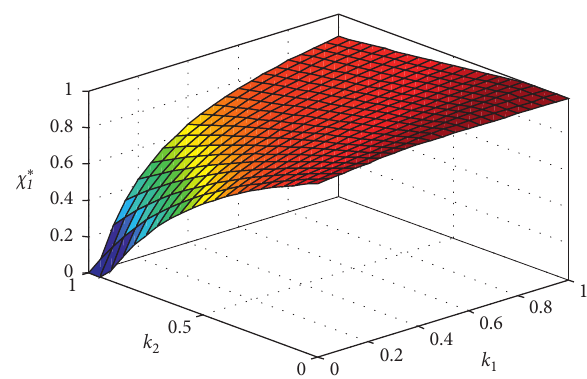
Figure 2: Relationship between the effort degree of the design and the fairness concern behavior of both parties. enterprise χ ∗ 1